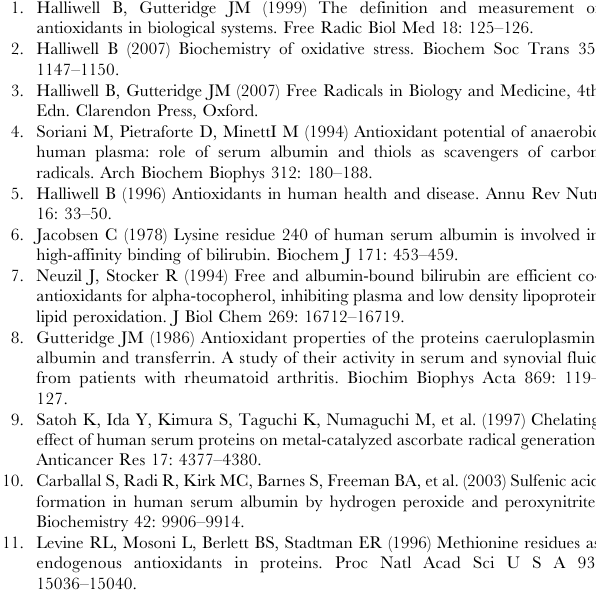
Figure S2 Assay procedure complemented information. The assay procedure is described as follows: to the luminometer cuvette, 800 m l of phosphate buffer solution pH 7.4 and 200 m l of reaction mix are added (dilution 1:10 with PBS). Before the cuvette is placed in the luminometer (BioOrbit, Turku, Finland), 100 m l of Horseradish peroxidase (5 m U/l) are added and then mixed well, allowing the light emission to stabilize. The temperature of the system was maintained at 25 6 2 u C. The chemiluminiscent signal remains stable for several minutes with an output of around 1600 mV. With the stable maximum signal the instruments carried out a run of precisely 3 minutes. The correspondent area below the curve represents the no-add antioxidant value (N). Any reductions of the absolute area below the curve during an identical run using standard or sample correspond to the antioxidant capacity of the test solution and (C) represents the remaining area. Table S1 Antioxidant capacity and protein cysteine content. A correlation between antioxidant capacity and the total amount of cysteine residues per gram of protein (calculated) could be observed for human insulin, bovine albumin and carbonic